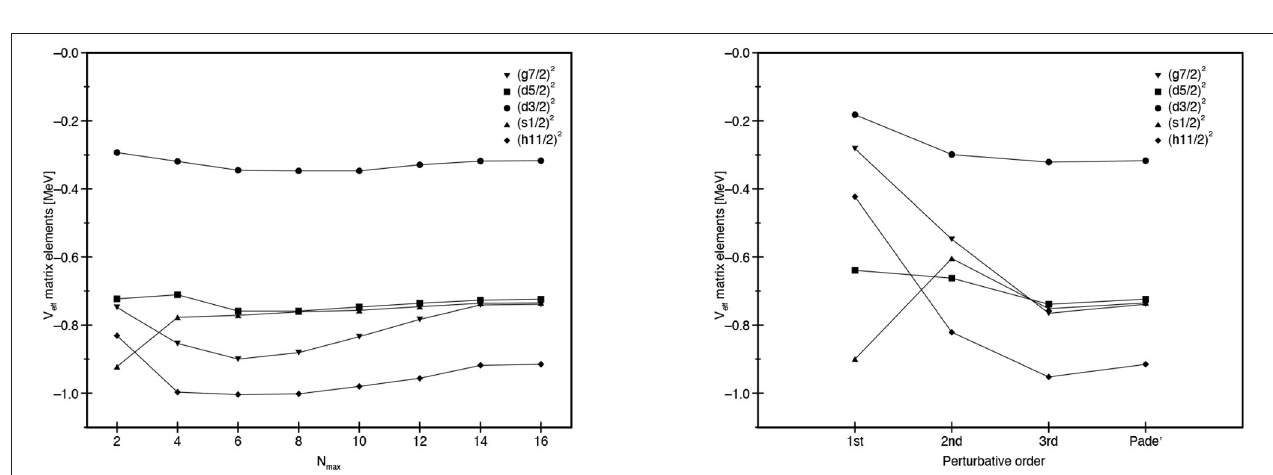
FIGURE 15 | Neutron SP energies as a function of N max (left) and of the perturbative order (right). Reproduced from reference [122] under the Creative Commons CC BY license.